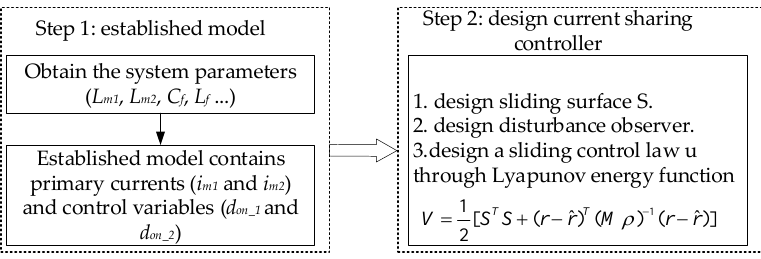
Figure 4. Flow chart for designing sliding mode current sharing controller.